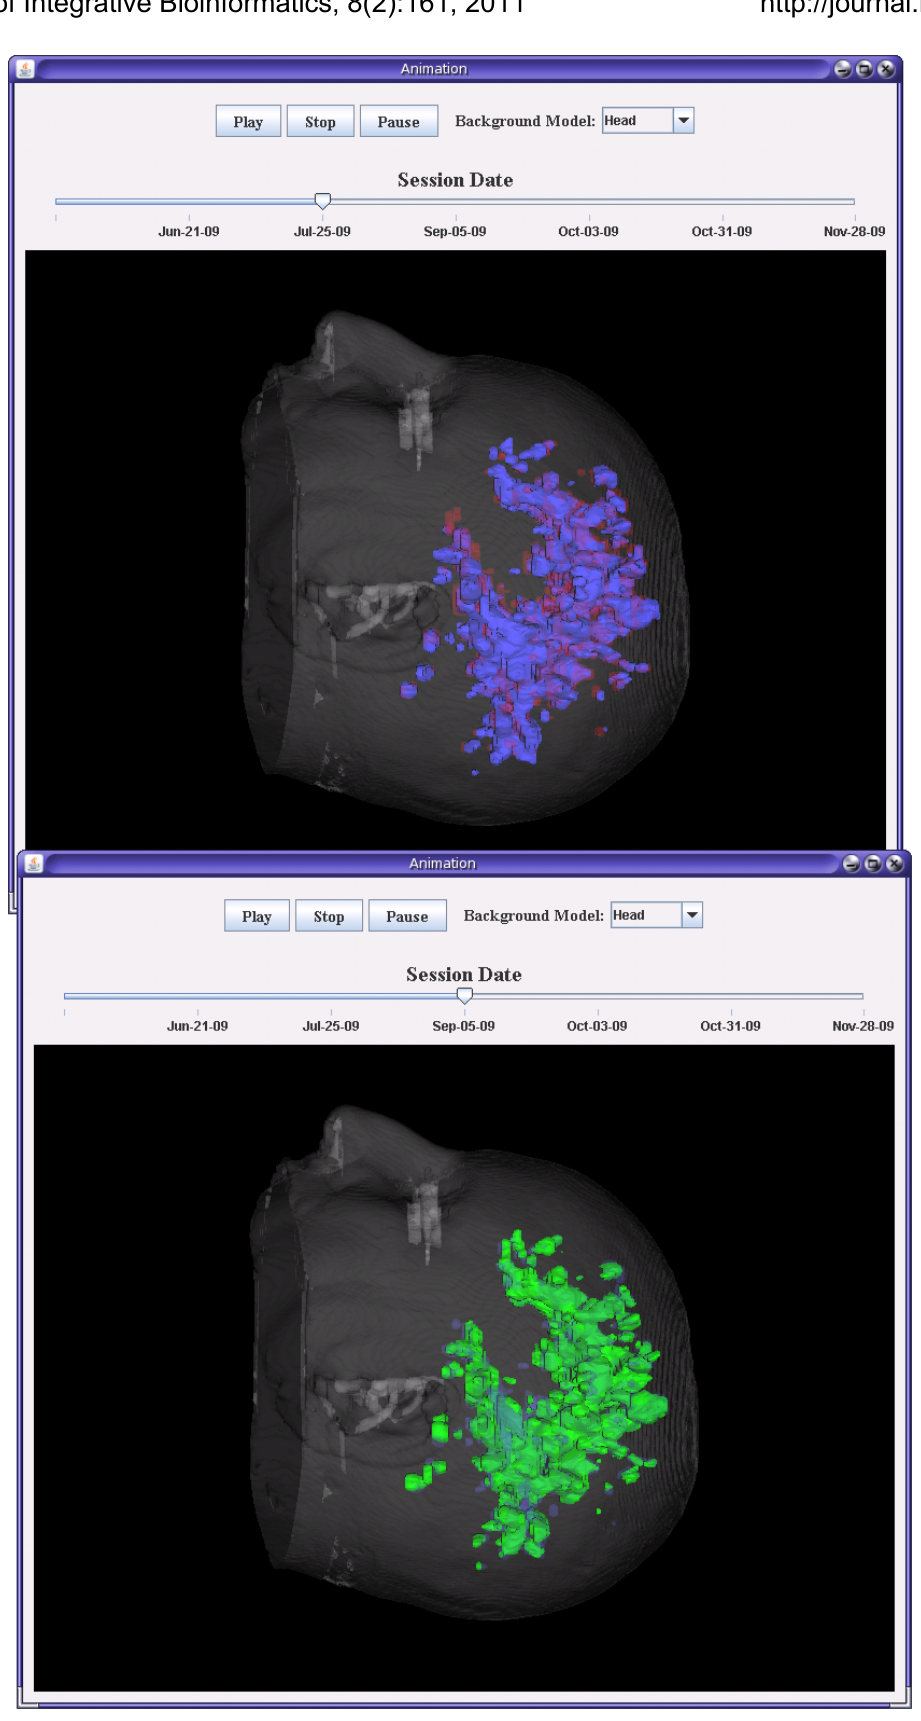
Figure 4. Animating changes in lesions over time. Two lesion models reconstructed from two scans acquired over time are shown. The slider bar shows the actual date of the scan. Different colors represent different time points, such that temporal changes between successive scans are